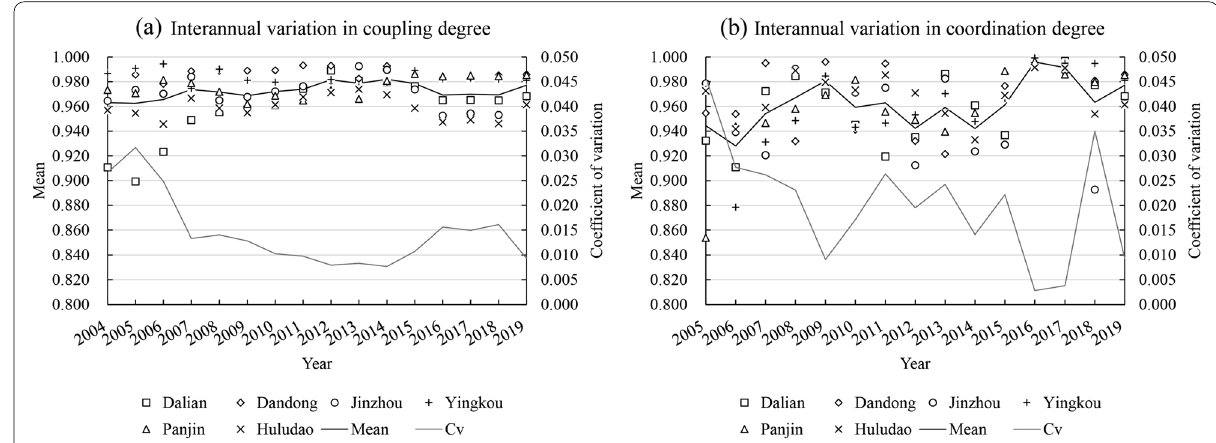
Fig. 4 Spatiotemporal coupling degree and coordination degree of comprehensive evaluation of the marine governance efficiency of the six coastal cities in Liaoning from 2004 to 2019